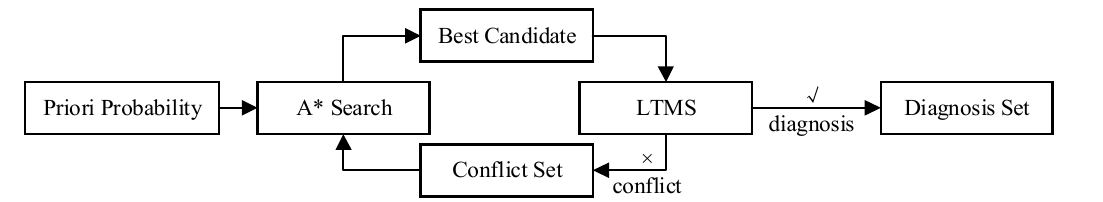
Figure 2. Framework of Conflict Directed A*.